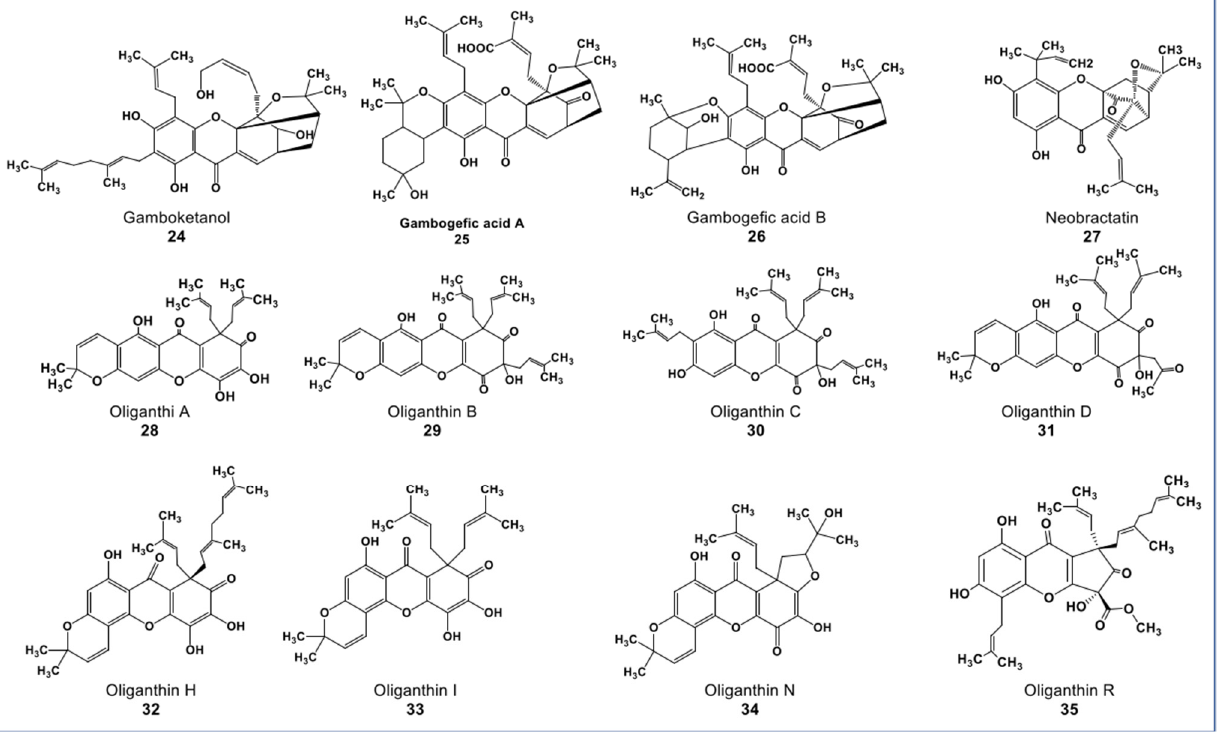
Figure 5. ( A ): Representative members of new xanthone phytochemicals from various plant sources (compounds 24 to 35 ). ( B ): Representative members of new xanthone phytochemicals from various plant sources (compounds 36 to 42 ). Some new xanthones from Garcinia oligantha were reported to be cytotoxic against many cancer cell lines [84–87]. Compounds 28 – 38 (Figure 5A,B) had IC 50 values ranging from 1.52–<20 µM against A549, HepG2, HT-29, PC, HL-7702, and HeLa cells [86]. Com- pound 35 (Figure 5A) showed cytotoxic activities against quiescent prostate cancer cells (LNCaP) that are insensitive to Taxol at 20 µM [84]. Xanthones from other plants source